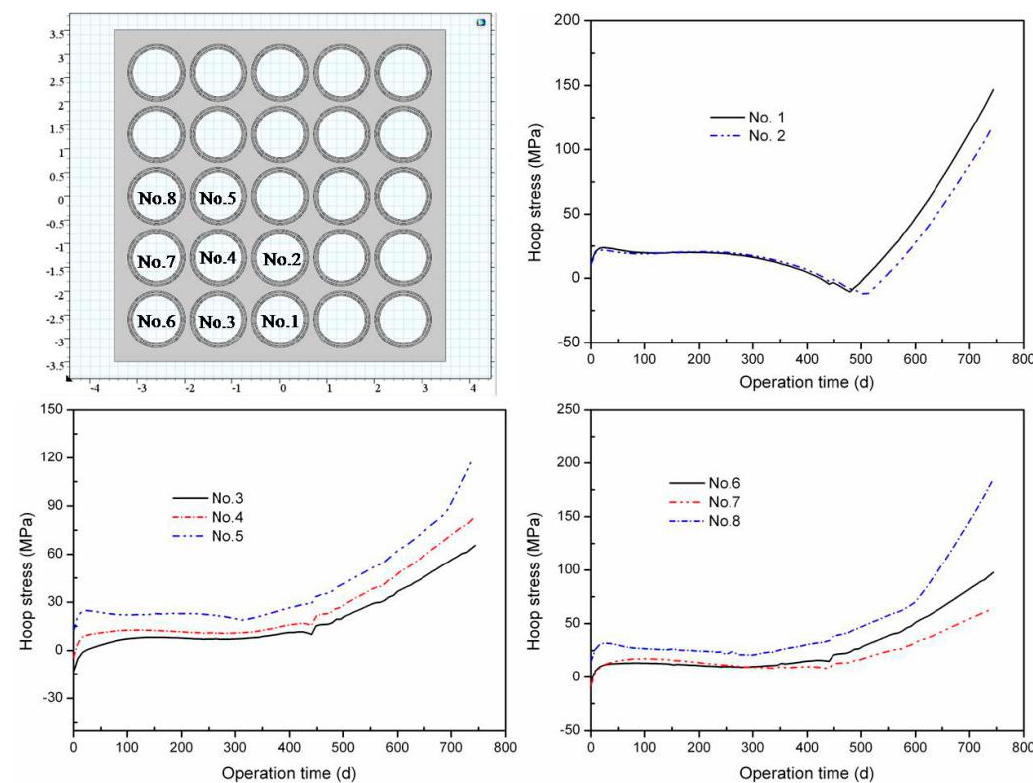
Figure 10. Variation of hoop stress on the SiC layer located in different parts in the FCM pellet.